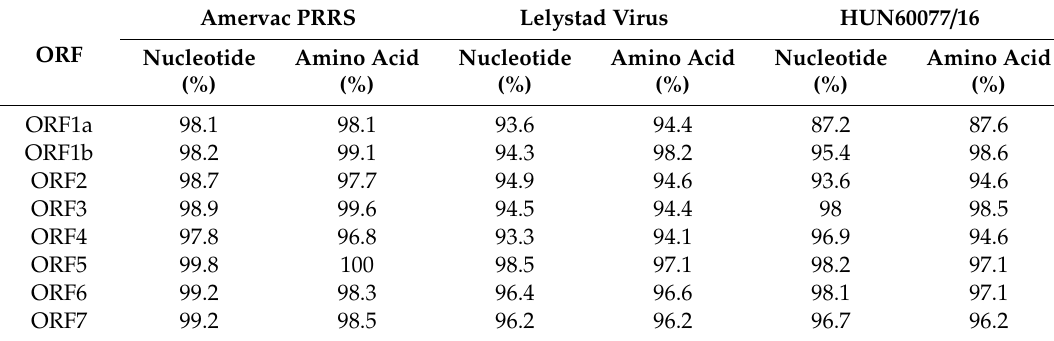
Table 2. Sequence identities of nucleotide and amino acid sequences between PRRSV / NPUST- 2789-3W-2 / TW / 2018 and the reference strains.